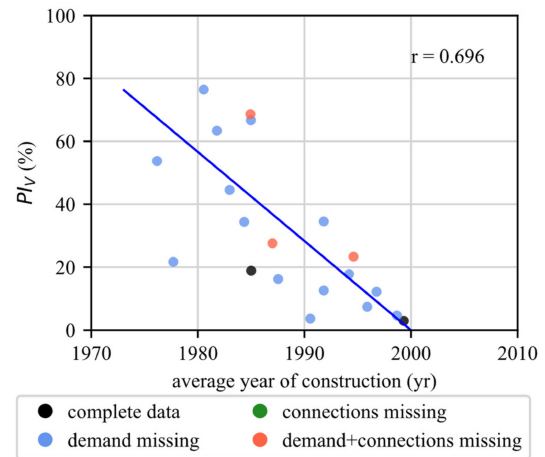
Figure 4. Correlation of volume related PI ( PI V ) with average year of construction.